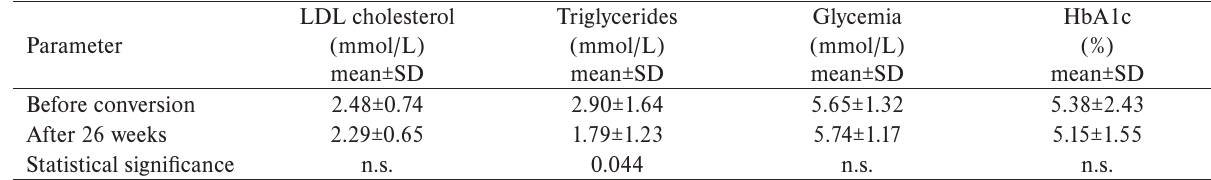
Table 2. parameters of lipid and glycide metabolism before and after conversion.